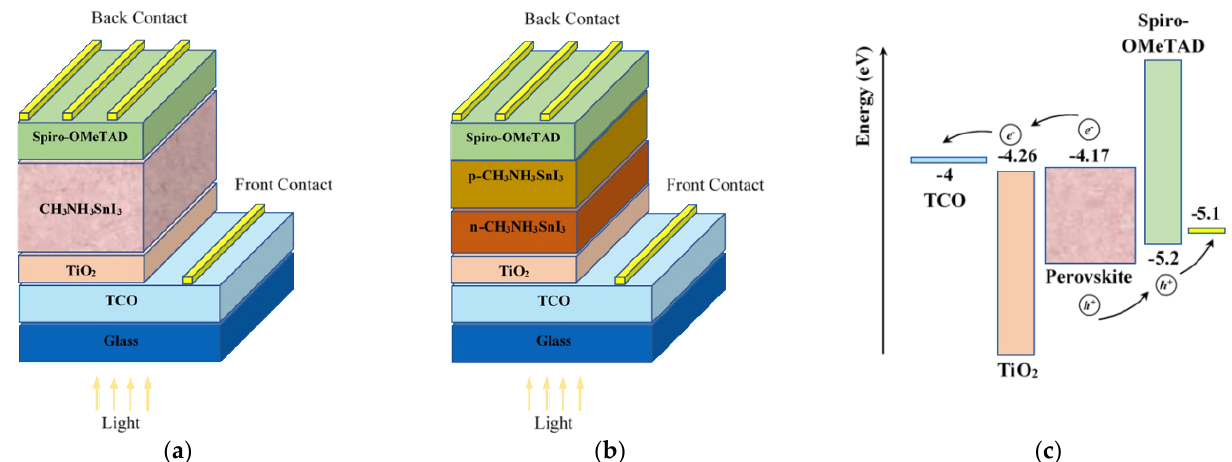
Figure 1. ( a ) A schematic representation of the conventional pin lead-free PSC, ( b ) the proposed hybrid hetero-homo junction-based structure, ( c ) the energy level diagram of the conventional pin structure showing how carriers are transported across the layers.